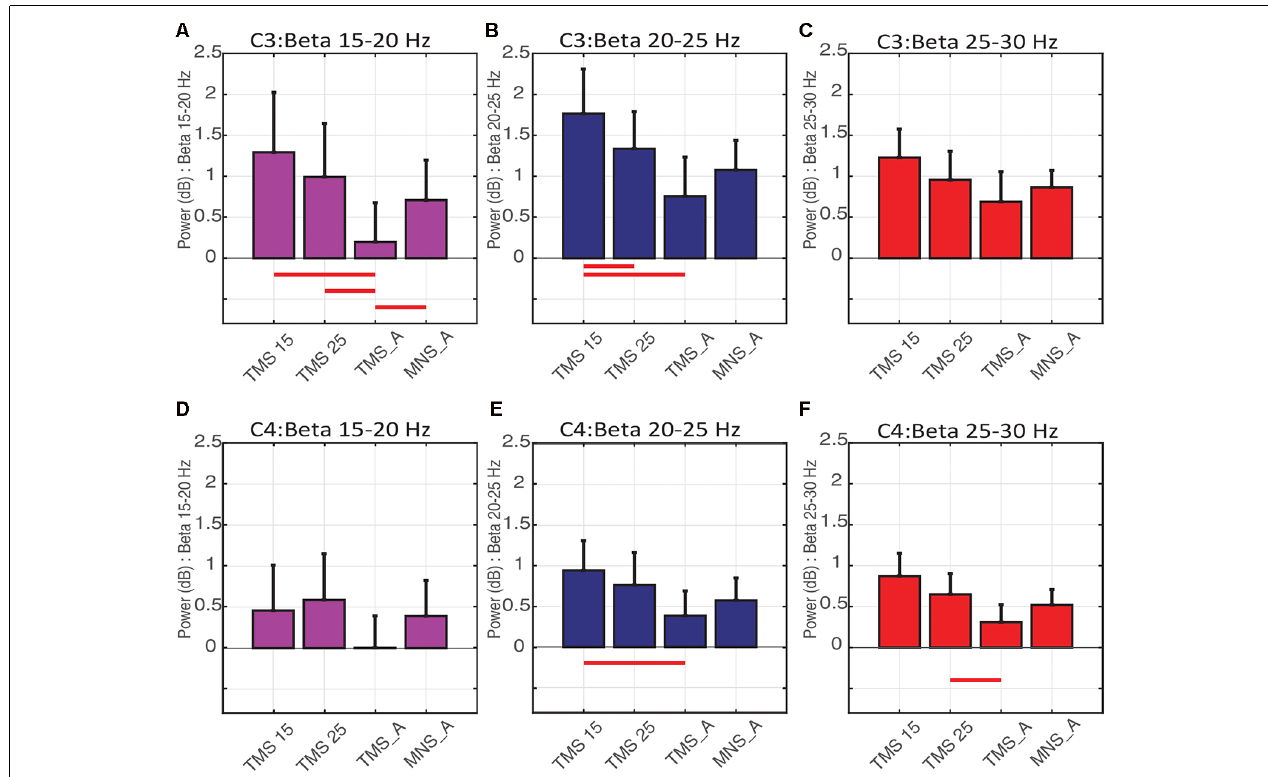
FIGURE 6 | Beta rebound statistics separated into three sub-bands (mean ± SEM). The histograms show the beta rebound power in a 500-ms window (from 500 to 1,000 ms), separately for low (15–20 Hz; A–D ), middle (20–25 Hz; B–E ), and high (25–30 Hz; C–F ) sub-bands. The upper panels show results for electrode C3 ( A–C ) and below for C4 (D–F) . Each histogram shows power values and statistical comparisons across the four experimental conditions (TMS15, TMS25, TMS_A, MNS_A). Red horizontal lines represent significant differences between conditions ( p < 0.05).